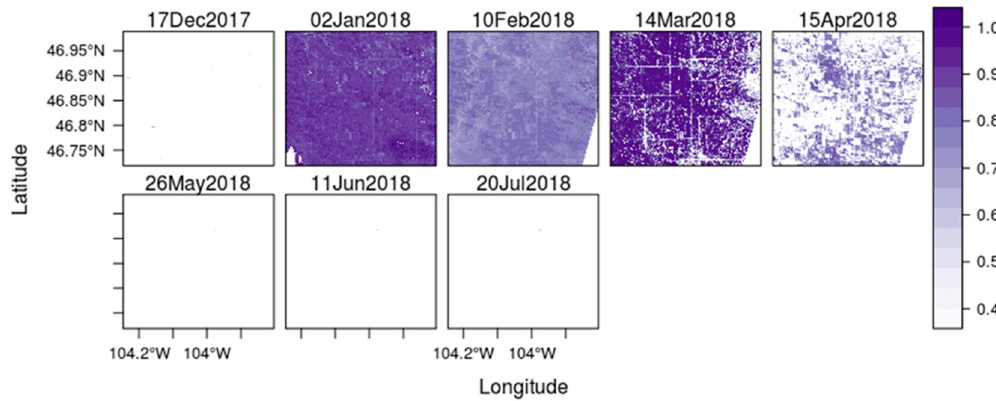
Figure 6. Snow-covered area (SCA, 2017–18), North Dakota, from Landsat-8 data (cloud free days) at 30 m resolution. White areas in the images indicate snow-free conditions; light to dark colors represent the Normalized Difference Snow Index (NDSI) values from low (~0.4: some snow present) to high (1; snow covered pixel and other mixed snow and other cold surfaces such as roads).